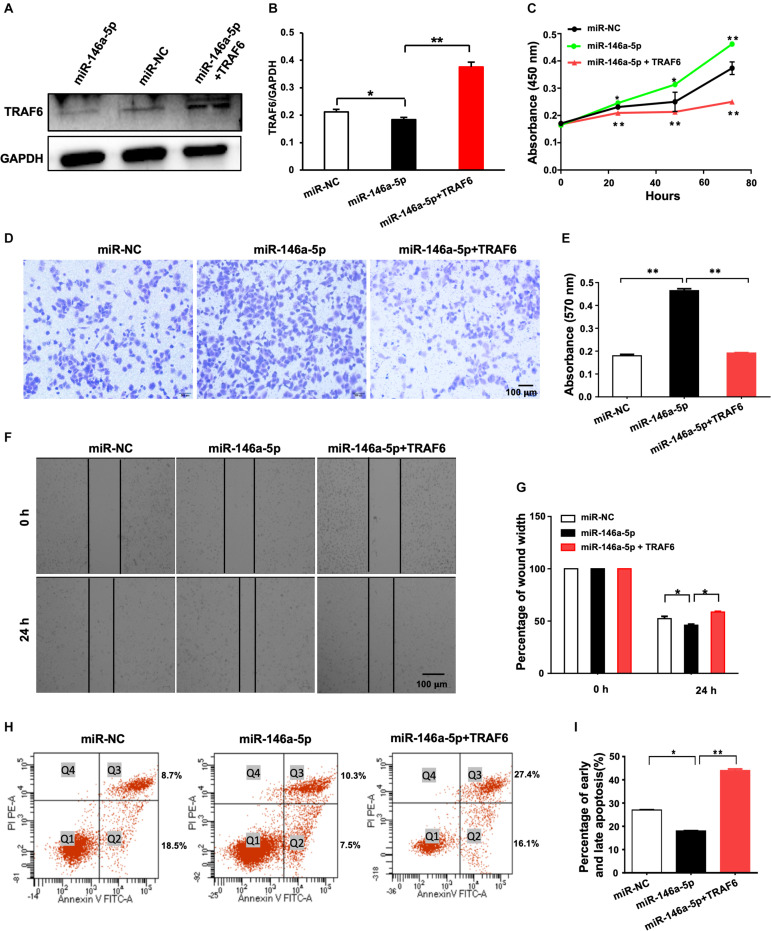
Overexpression of TRAF6 reverses the oncogenic effects of miR-146a-5p in NSCLC cells. (A) The protein level of TRAF6. (B) Quantitation of the WB data as in (A). (C) Cell proliferation examined by CCK-8 assay. (D) Migration ability detected by transwell assay. (E) Quantification of the transwell assay result as in (D). (F) Migration ability measured by wound-healing assay. (G) Quantification of the wound-healing assay result as in (F). (H) Early (Q2) and late apoptosis (Q3) measured by flow cytometry analysis. (I) Quantification of the FACS data as in (H). All experiments were performed in H1299 cells.